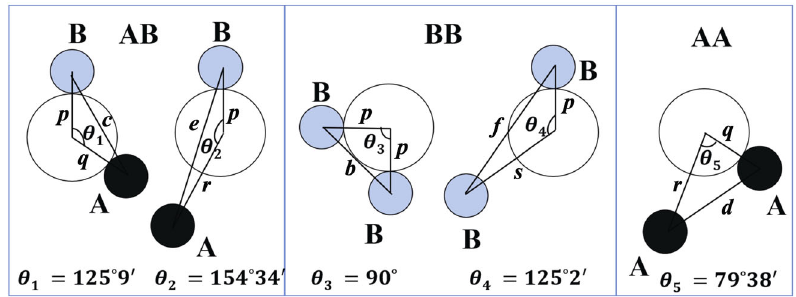
Fig. 3 Representations of angles and distances between cation–anion and cation–cation at A and B